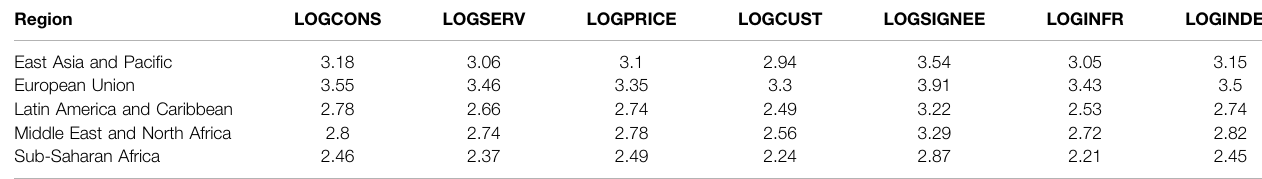
TABLE 2 | Regional comparison of trade facilitation measures on LPI. Region